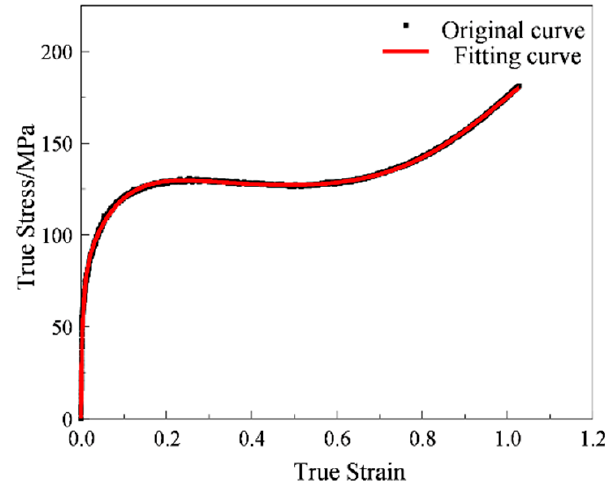
Figure 6. Original and fitting curves for flow-stress of S280 steel at a deformation temperature of 1150 °C and strain rate of 1 s − 1. Table 1. Flow-stress fitting curve equation coefficients for S280 steel at a deformation temperature of 1150 °C and strain rate of 1 s − 1.